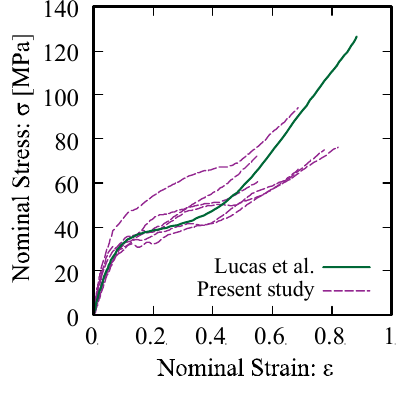
Fig. 10 Comparison of the stress-strain diagrams of byssal threads (obtained by Lucas et al. and the present study).